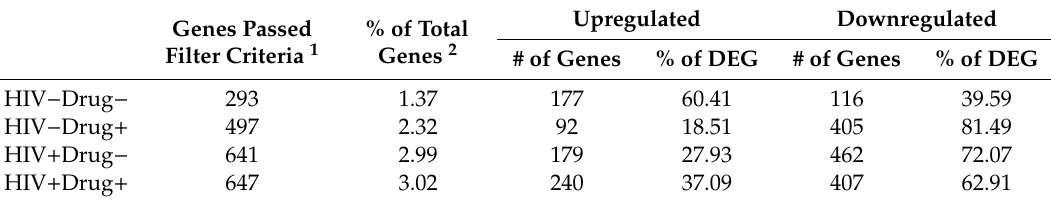
Table 3. Summary of the DEG in the four clinical groups (n = 3) as compared to vehicle 1 . Genes Passed Filter Criteria